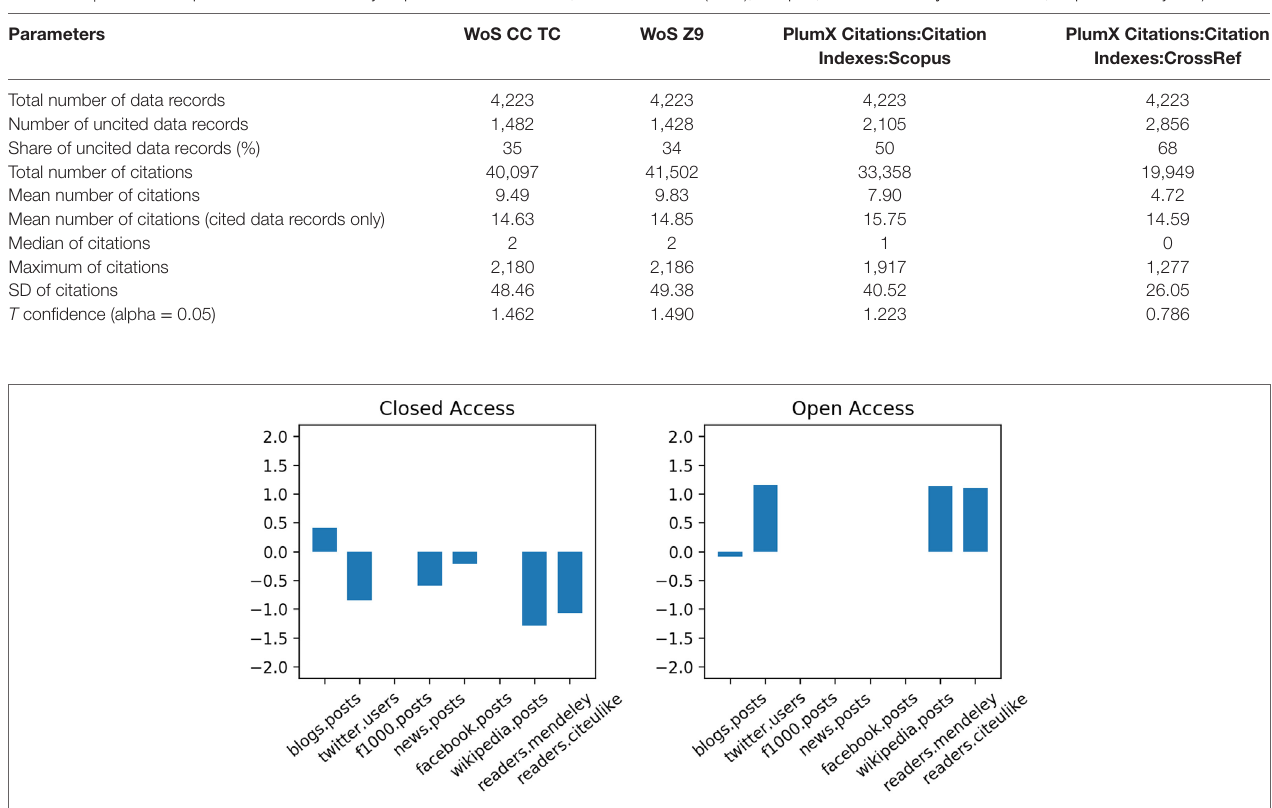
FigUre 3 | Relationship between altmetrics, and access rights of Zenodo data records. Closed access combines data records with closed, embargoed, and restricted access (data from Altmetric.com, publication years <